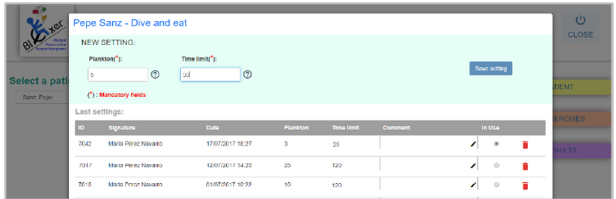
Fig. 13. Super-Administrator view of the exercises defined for a game. Example for the game Phiby’s Adventures which contains four exercises (Dive, Chop, Row and Climb). On the left, the tabs “Centres” and “Admin” give access to administrate health centres and their staff. “Games” gives access to administrate different games.